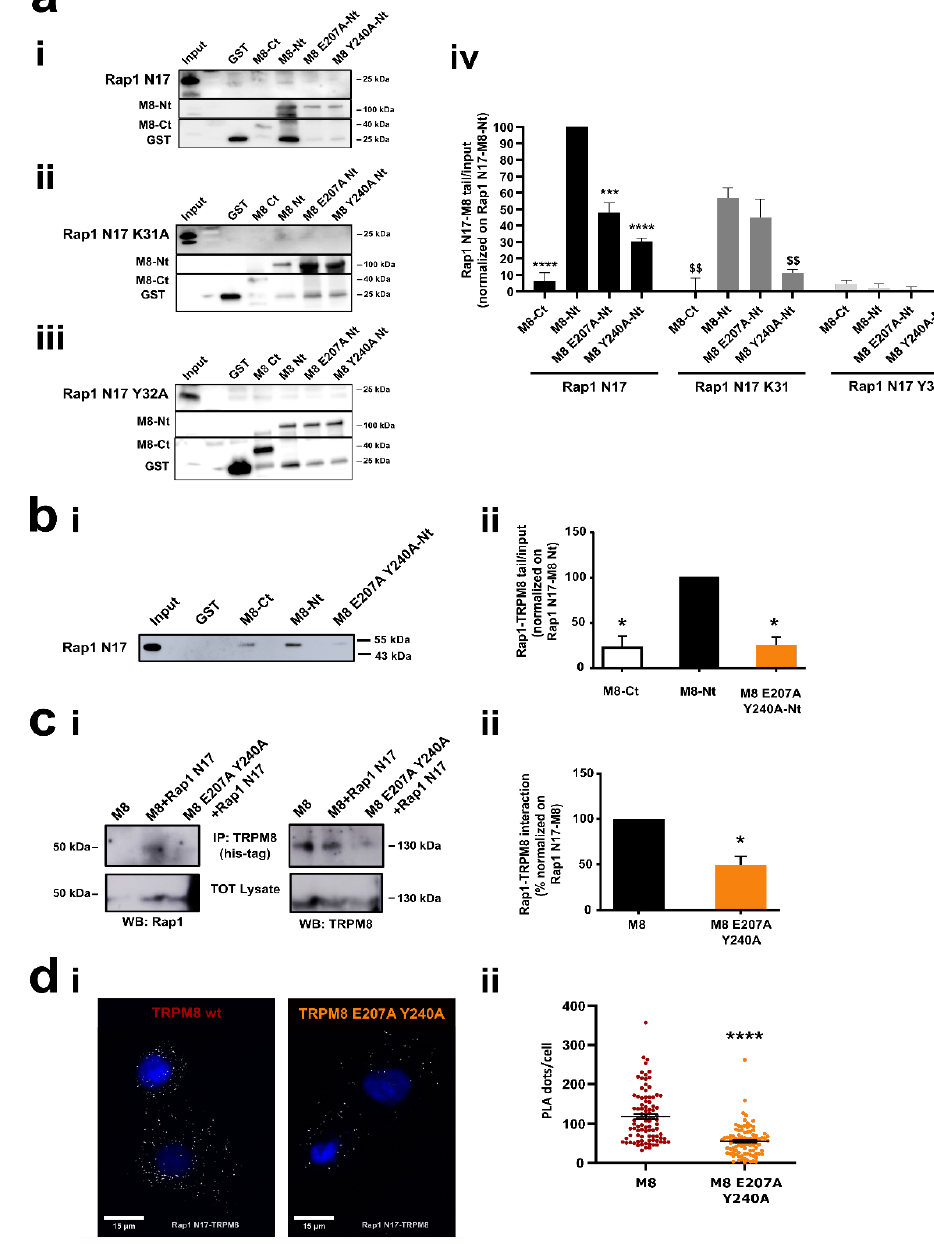
Figure 6. TRPM8 mutants’ characterization. ( a ) GST pull-down assay on GST, TRPM8 wt C-terminal tail (M8-Ct), TRPM8 wt N-terminal tail (M8-Nt), TRPM8 E207A N-terminal (M8 E207A-Nt) and TRPM8 Y240A N-terminal (M8 Y240A-Nt), incubated with in vitro translated Rap1 N17 ( ai ), Rap1 N17 K31A ( aii ) and Rap1 N17 Y32A ( aiii ). 5% of the lysates were used for the input of the GST pull-down. Western blotting was performed with an anti-Rap1 antibody and one representative experiment out of three is shown. The original uncropped blots are reported in Figure S5. ( aiv ) Quantification of Rap1 N17-TRPM8 tails interaction normalized on the input. Values are normalized on Rap1 N17-M8-Nt ratio and data are expressed as mean ± SEM. Statistical significance versus Rap1 N17-TRPM8-Nt, ***: p < 0.001; ****: p < 0.0001; statistical significance versus Rap1 N17 K31-TRPM8- Nt, $$: p < 0.01 ( Student’s t -test). ( bi ) GST pull-down assay on GST, M8-Ct, M8-Nt and M8 E207A Y240A-Nt, incubated with lysates of PC3 cells overexpressing GFP-Rap1 N17. 5% of the lysates were